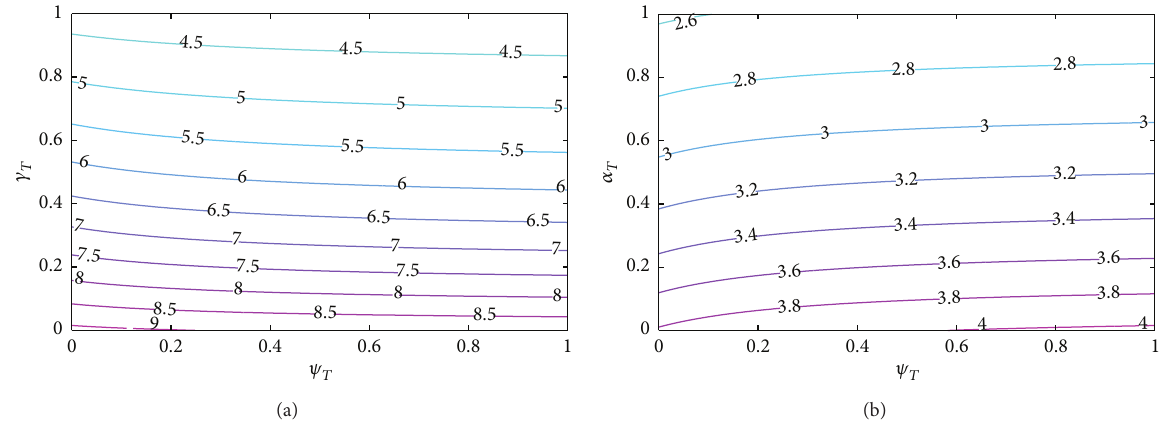
Figure 4: Contour plot of the reproduction number ( R 𝑇 ) of model (2) as: (a) a function of return rate from lost to follow-up ( 𝜓 𝑇 ) and treatment rate ( 𝛾 𝑇 ); (b) a function of return rate from lost to follow-up ( 𝜓 𝑇 ) and treatment rate ( 𝛼 𝑇 ). Parameter values used are as given